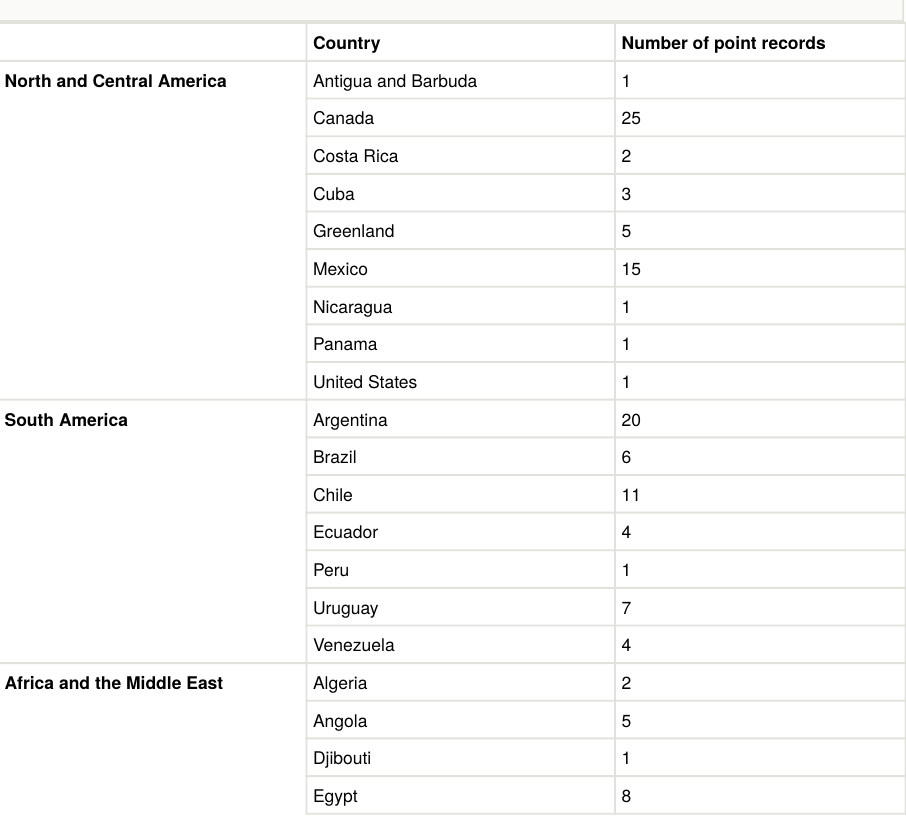
Table 2. The number of saltmarsh point locations per country in the “Global Distribution of Saltmarsh” point